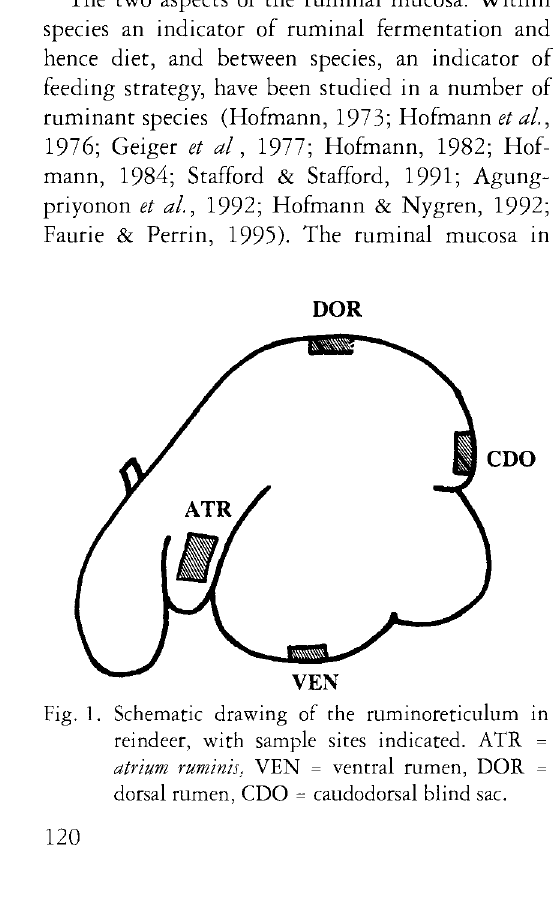
Fig. 1. Schematic drawing of the ruminoreticulum in reindeer, with sample sites indicated. ATR = atrium ruminis, VEN = ventral rumen, DOR = dorsal rumen, CDO = caudodorsal blind